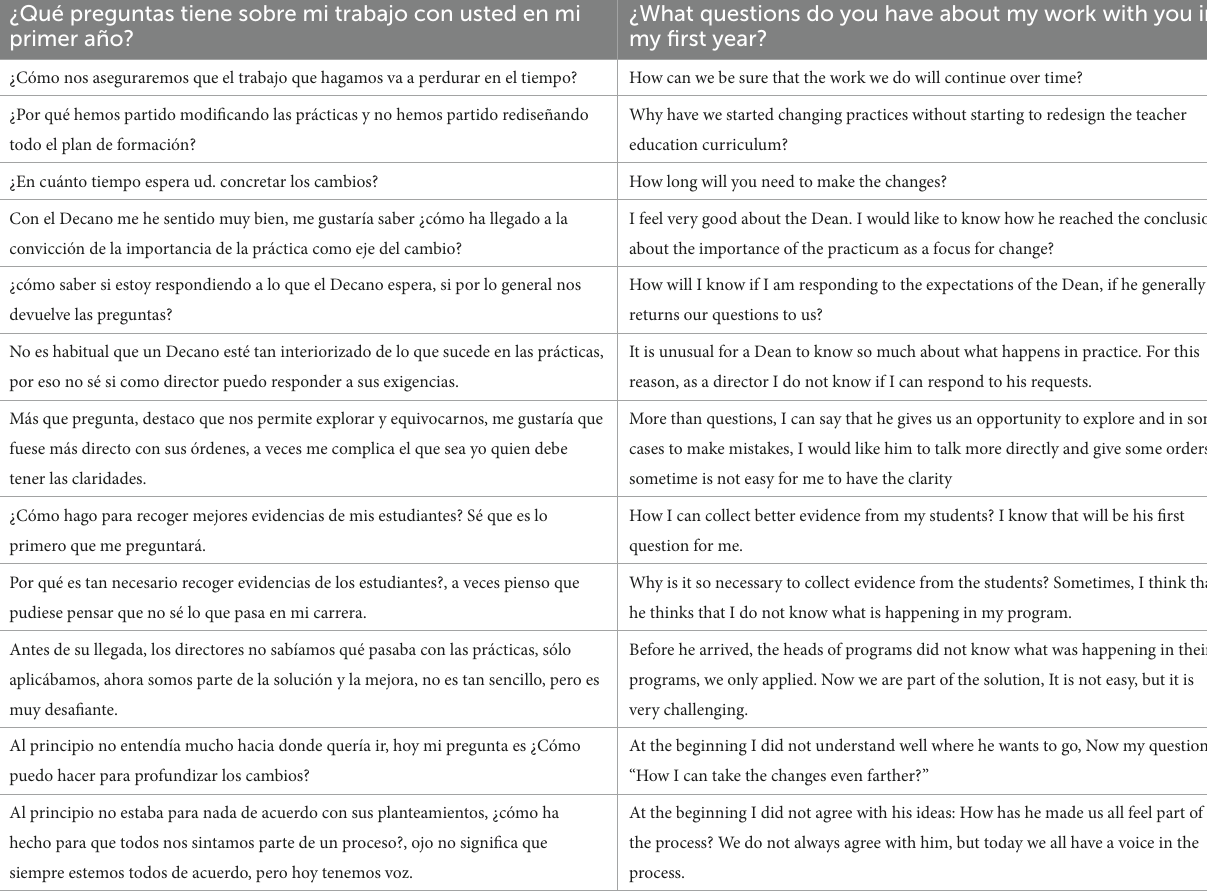
TABLE 1 Anonymous responses from department